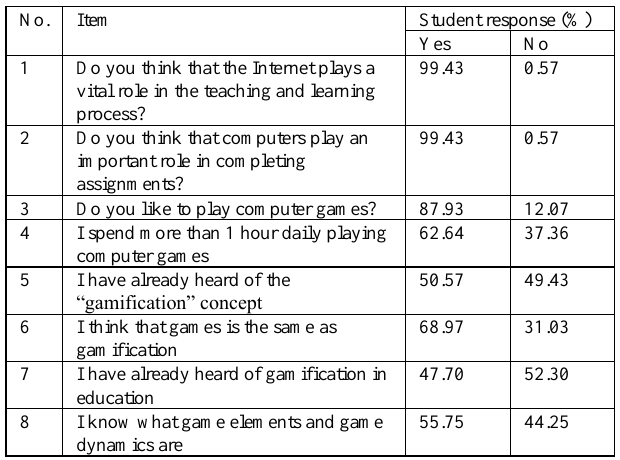
Table 4. Perceptions and prior experiences of games